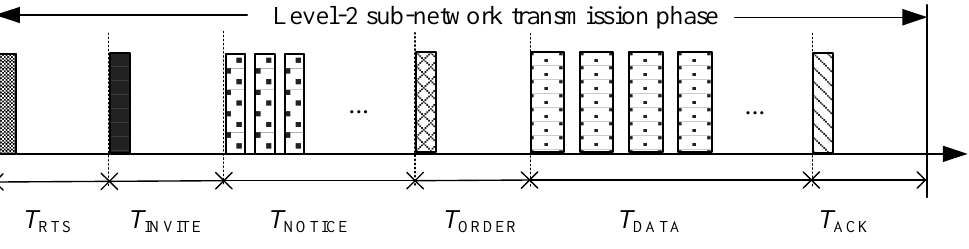
Figure 8. The transmission period of CT-MAC protocol.